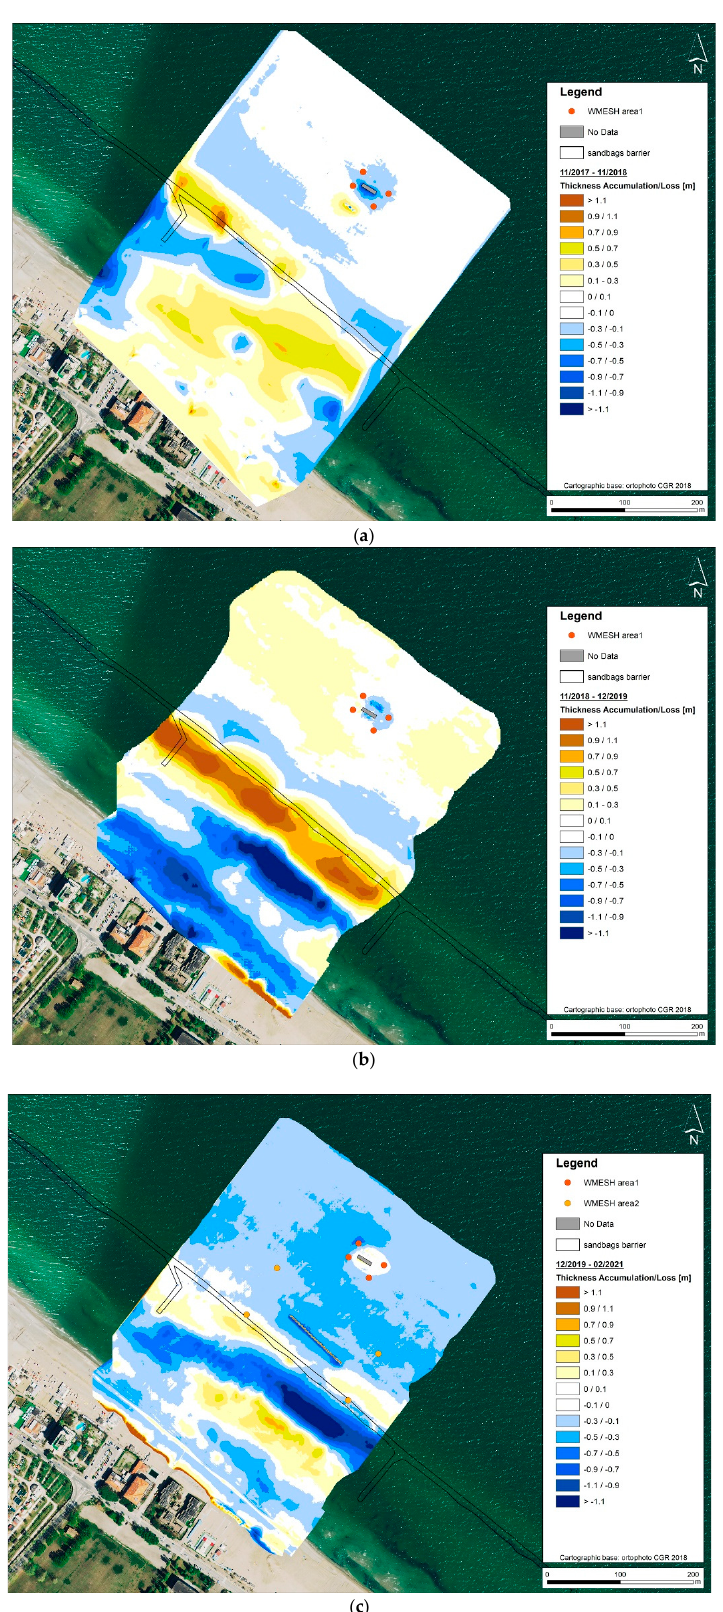
Figure 8. Difference maps between: ( a ) November 2017 and November 2018; ( b ) November 2018 and December 2019; ( c ) December 2019 and February 2021 DTMs. December 2019; ( c ) December 2019 and February 2021 More intense morphological changes result from the November 2018–December 2019 DTMs comparison (Figure 8b). Height decreases up to − 1.5 m are observed on the emerged